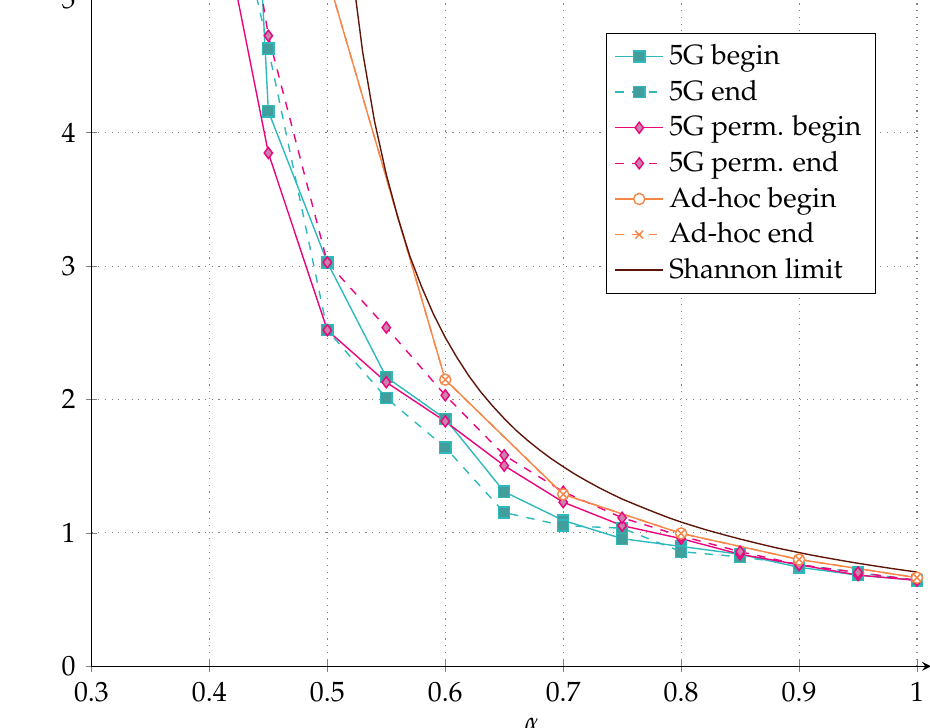
. Ad-hoc corresponds to 5G